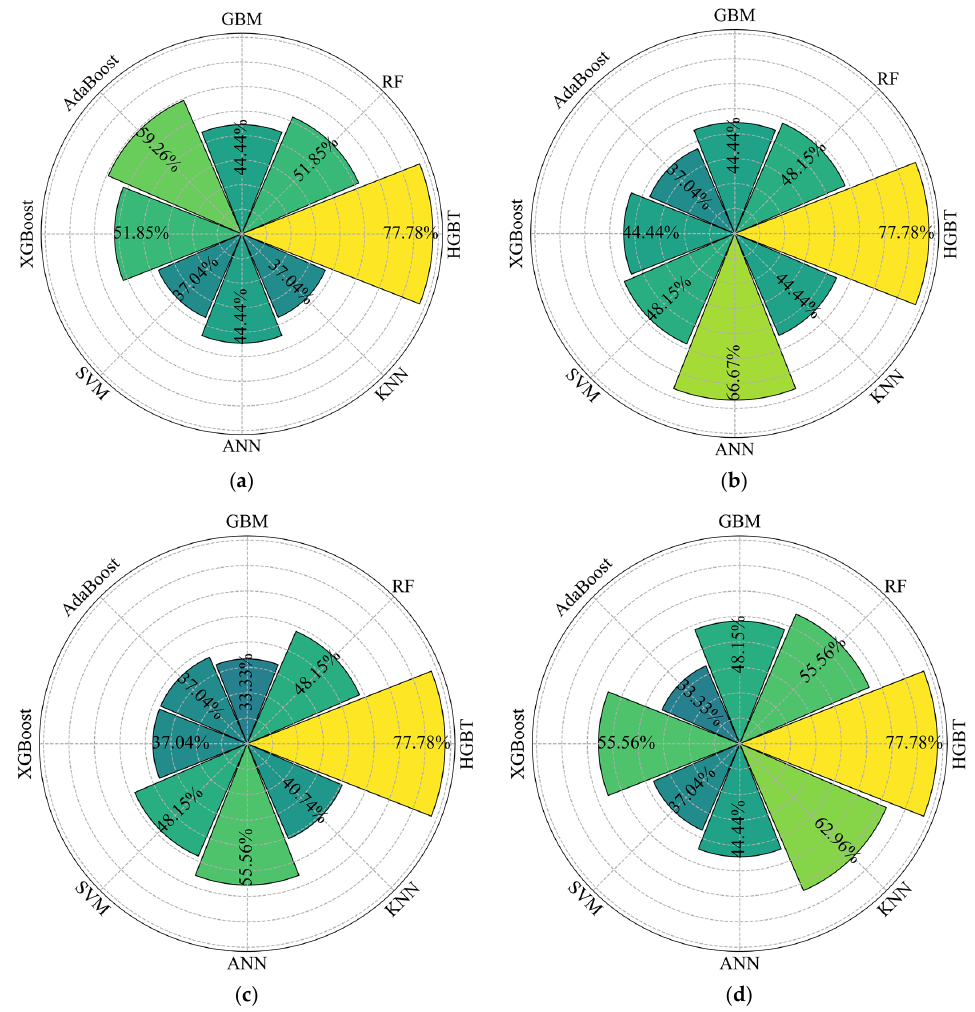
Figure 11. Model comparison in the incomplete database filled by: ( a ) 0; ( b ) mean value; ( c ) median value; ( d ) the most frequent value.